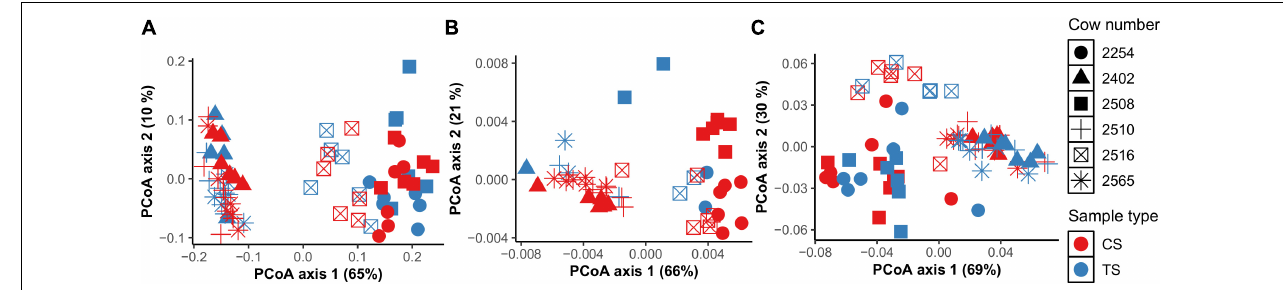
FIGURE 1 | Comparison of DNA-based bacterial (A) and archaeal (B) community composition between sample types TS (tube solid) and CS (cannula solid), and between individual cows using principal coordinate analysis (PCoA) based on weighted UniFrac distances. PCoA based on Bray Curtis distances using VFA profiles (C) between sample types TS (tube solid) and CS (cannula solid) and between individual cows.